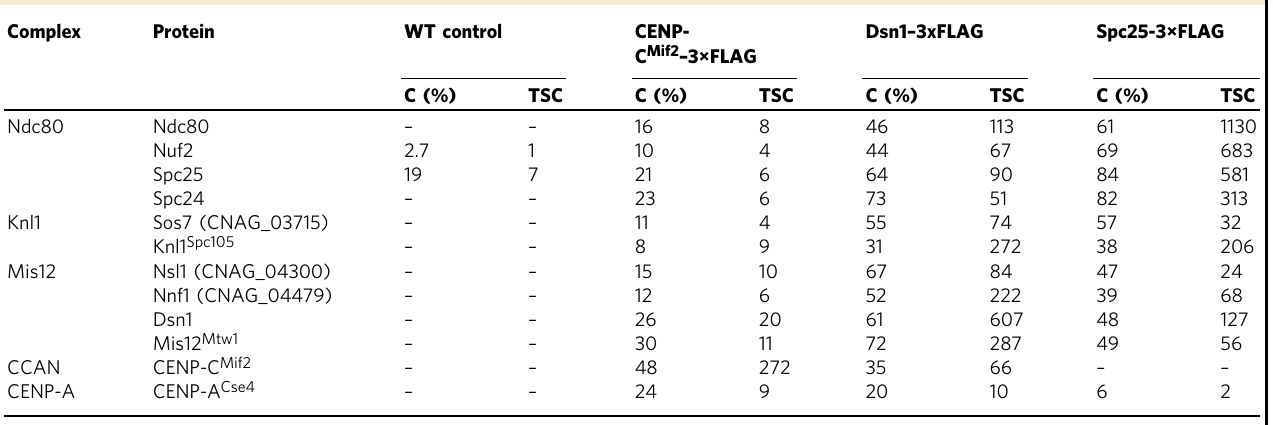
Table 1 List of kinetochore proteins obtained in the kinetochore IP –